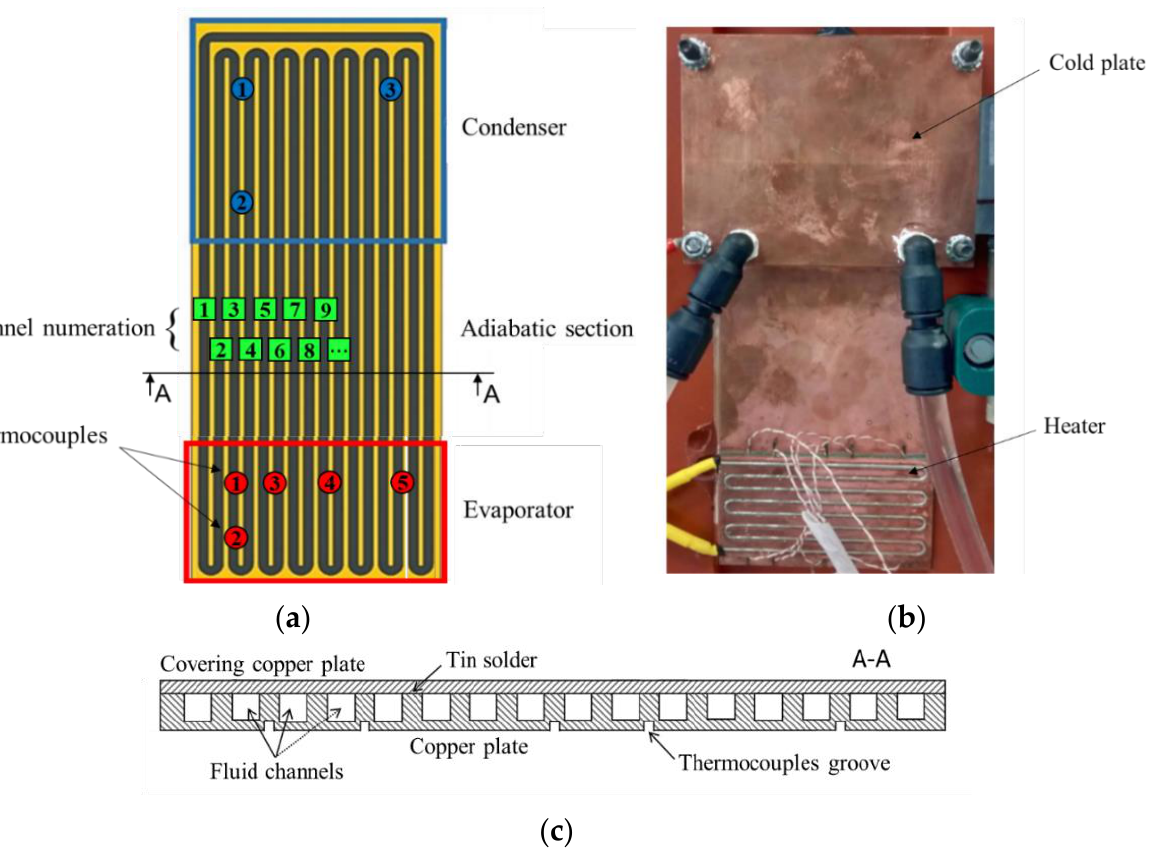
Figure 1. FPPHP channels layout, with reference to the thermocouples location (circles) and channel numeration (squares) ( a ); rear side of the FPPHP ( b ); A-A cross section ( c ).